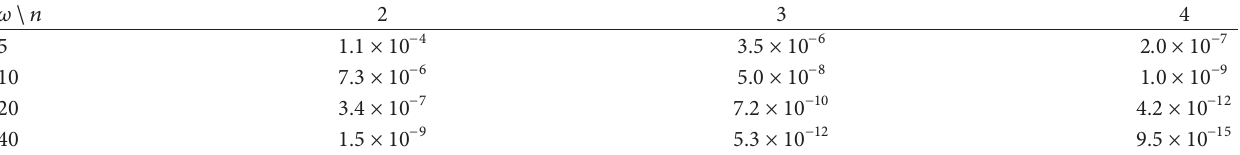
1 (𝑥+1) −(1/2) (1−𝑥) −(1/2) 𝑒 𝑥 𝑒 𝑖𝜔𝑥 𝑑𝑥 , compared −1